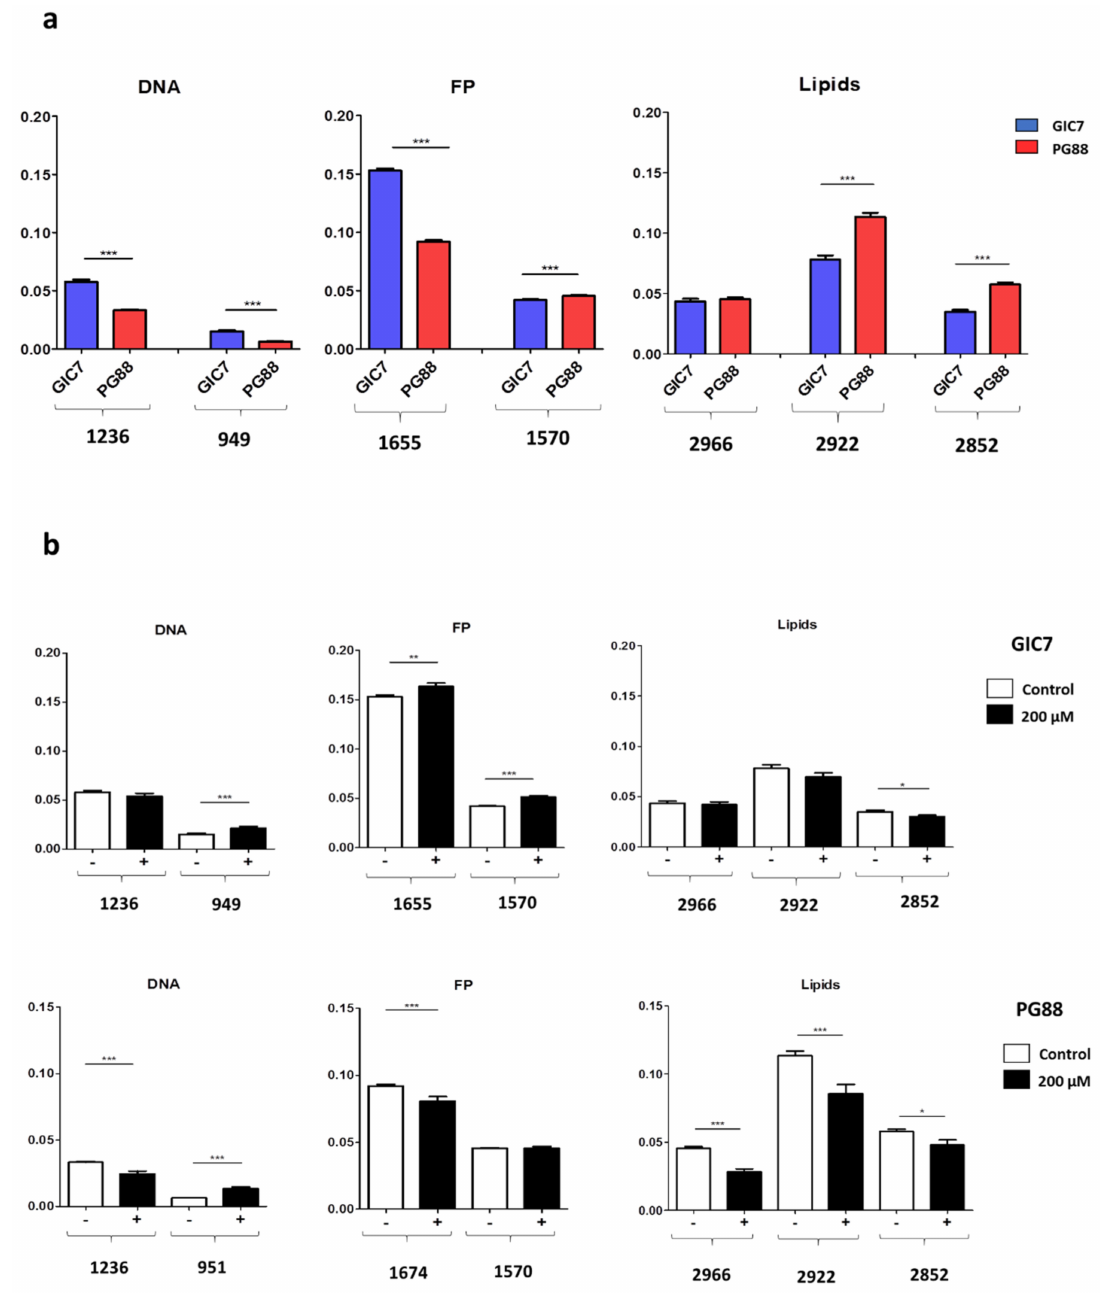
Figure 11. Comparison between GIC7 and PG88 analyses by SR-FTIRM- Histogram plots are representative from DNA, protein, and lipid peaks: ( a ) comparison between untreated GIC7 and PG88 cells and ( b ) comparison between treated cells with 200 µ M Na[ o -COSAN] 5 h with regard the respective untreated control cells (black and white columns, respectively), upper part GIC7 and PG88 at the bottom part. Significant differences by t -test, * p < 0.05; ** p < 0.01; *** p < 0.001 are pointed out at the corresponding